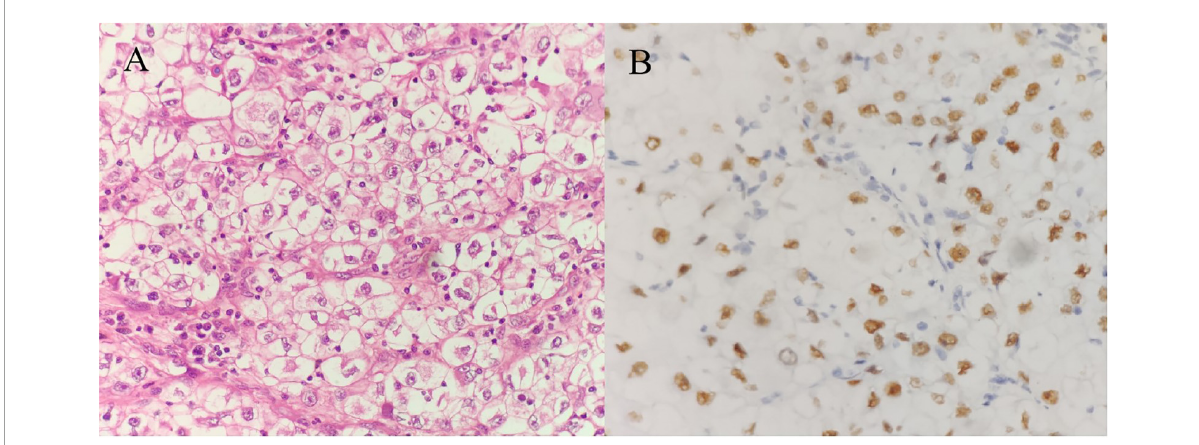
FIGURE3 Pathological and immunohistochemical (IHC) findings. Post-operative pathological findings (A) reveal clear cell carcinoma (left retroperitoneal),the large polygonal tumor cells with transparent cytoplasm are arranged in a nest like manner, and the stroma is rich in small blood vessels. IHC findings (B) :Pax8 immunohistochemical staining of tumor cells is positive, indicating its renal origin.